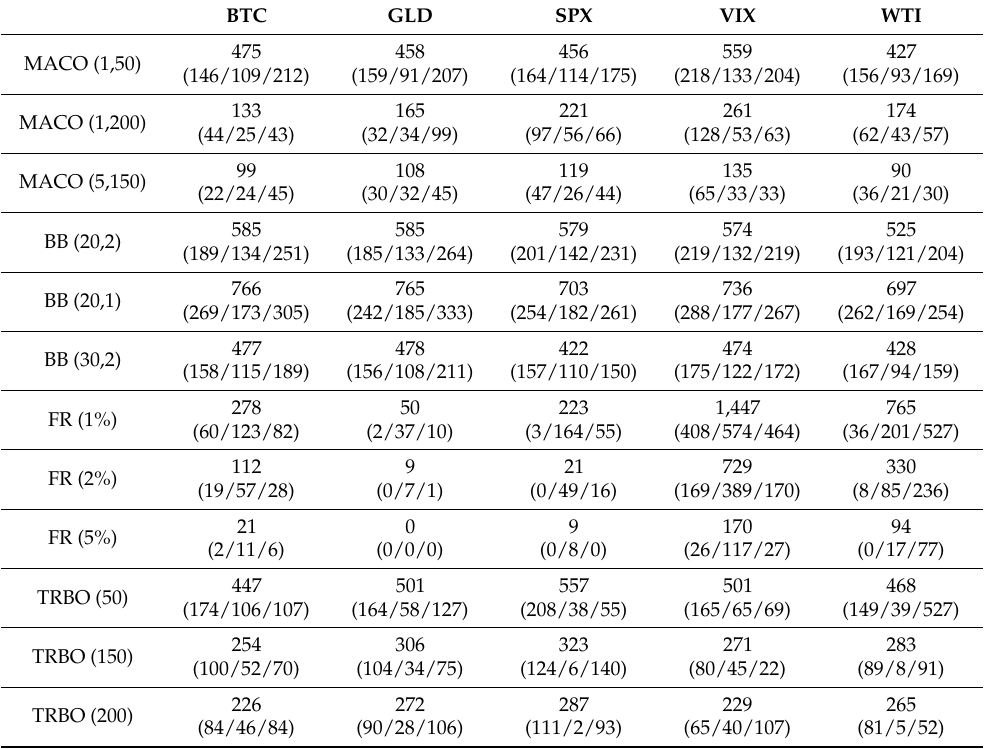
Table A1. Number of Trading Signals Generated by